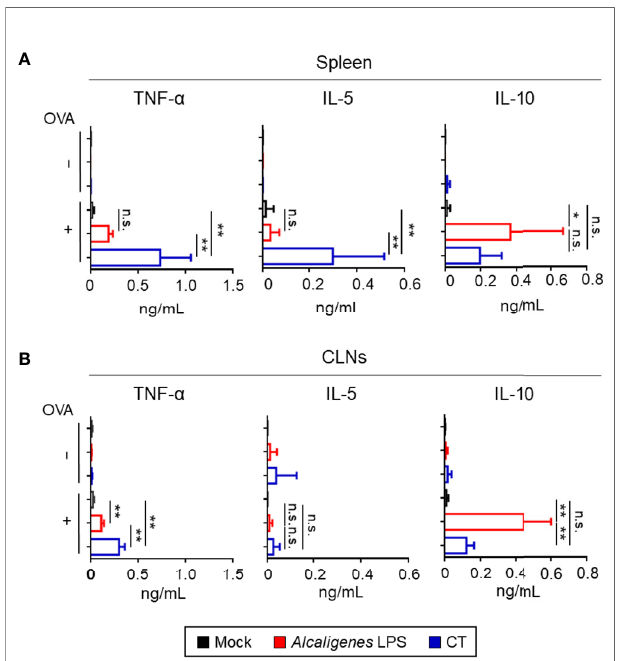
FIGURE 5 | Alcaligenes LPS has low In fl ammatory but high regulatory properties. Mice were nasally immunized three times with OVA alone (Mock) or with OVA plus Alcaligenes LPS or CT. One week after the fi nal immunization, the production of TNF- a , IL-5, and IL-10 in the spleen (A) and CLNs (B) of nasally immunized mice was surveyed after ex vivo stimulation by OVA (n = 6 per group). Data are representative of two independent experiments and were analyzed by one-way ANOVA (* p < 0.05; ** p < 0.01; n.s., not signi fi cant).